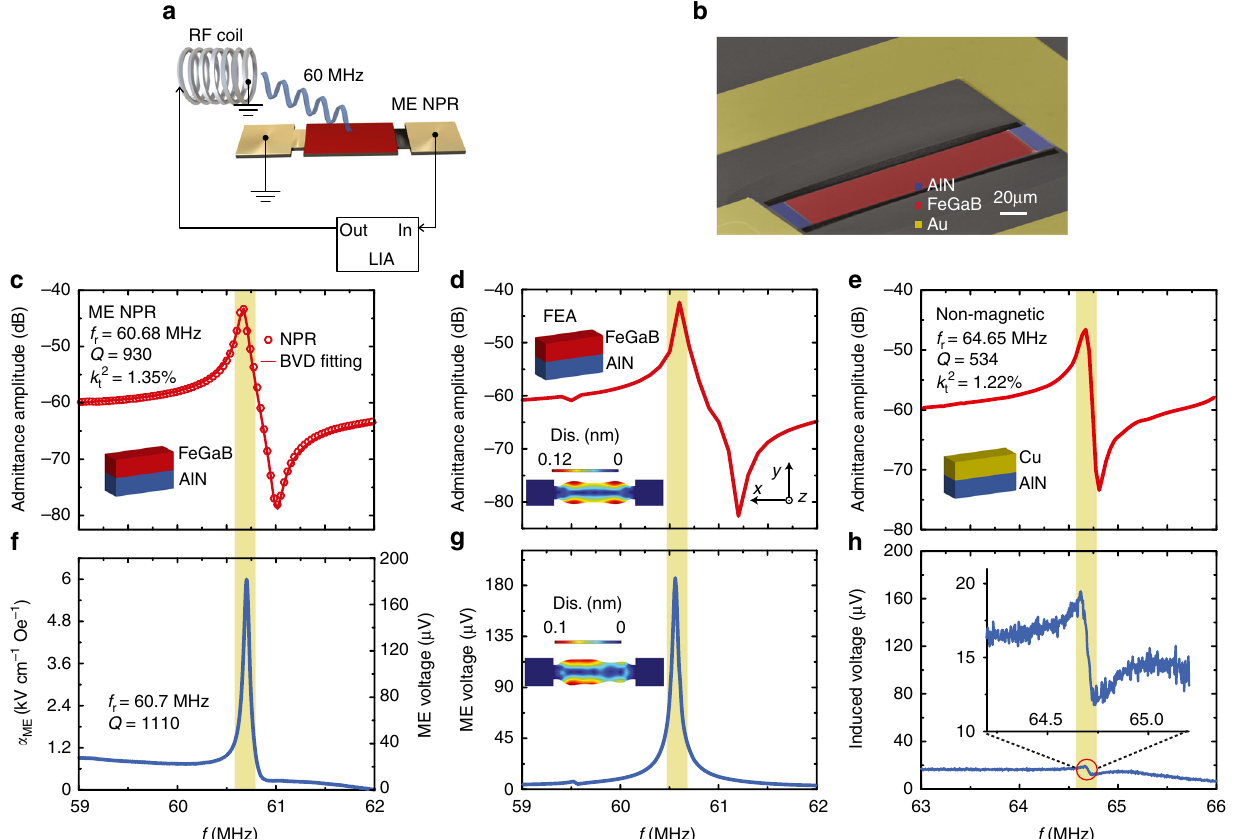
Fig. 1 ME NPR device with gigantic ME coupling. a Schematic representation of the magnetoelectric (ME) nanoplate resonator (NPR) and the induced ME voltage measurement setup by using a high-frequency lock-in ampli fi er (HFLIA). The RF magnetic fi eld ( H RF ) is generated by a RF coil. b Scanning electron microscopy (SEM) images of the fabricated the ME NPR. The red and blue areas show the suspended single nanoplate with FeGaB/AlN ME heterostructure and AlN anchors. The yellow area presents the RF ground-signal-ground electrode. c Admittance curve and Butterworth – van Dyke model 2 ) of 1.35%. fi tting of the ME NPR with a resonance frequency ( f fi cient ( k r ) of 60.68 MHz, quality factor ( Q ) of 930 and electromenchanical coupling coef t The inset shows the schematic of the cross-section of the ME heterostructure. d Finite element analysis (FEA) of ME NPR for the admittance amplitude. The inset shows the in-plane displacement of the nanoplate at resonance peak position and its coordinate system. e Admittance curve of a non-magnetic control sample which has a same device design as ME NPR. The inset shows the schematic of the device cross-section. f , ME coupling coef fi cient ( left axis ) and the induced ME voltage ( right axis ) versus the frequency of H RF excitation. g FEA of ME NPR for the induced ME voltage. The inset shows the in-plane displacement excited by H RF . h Induced voltage versus the frequency of H RF excitation for the non-magnetic device. The inset illustrates the zoomed-in view of the resonance peak area ( red circle